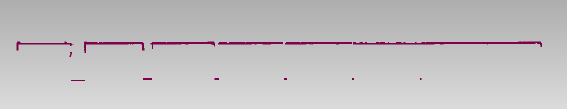
Figure 13. Team 2: Single point cloud recorded from the top Clear detection of pits for the geometry and the gap at the top of the structure from 3mm gap to 0.2mm gap.